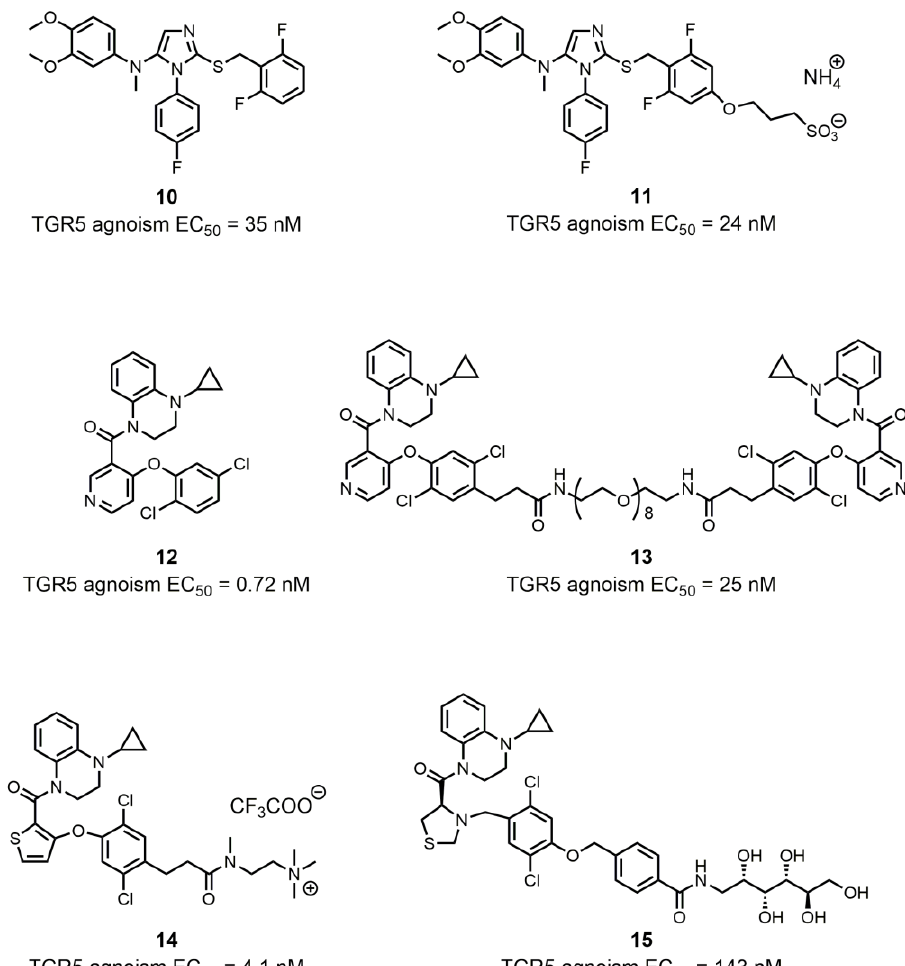
FIGURE 6: Synthetic intestinally targeted TGR5